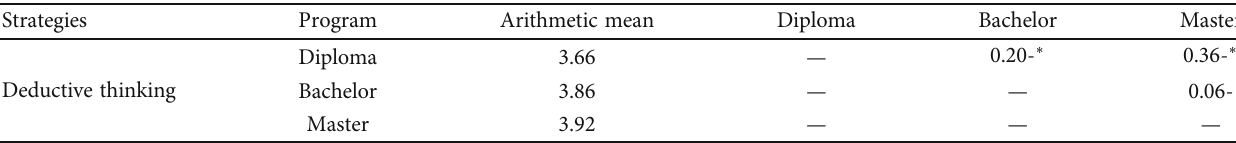
Table 7: The results of the Sche ff e test to examine the signi fi cance of the di ff erences between the arithmetic means of the dimension “ deductive thinking ” according to the student ’ s academic program